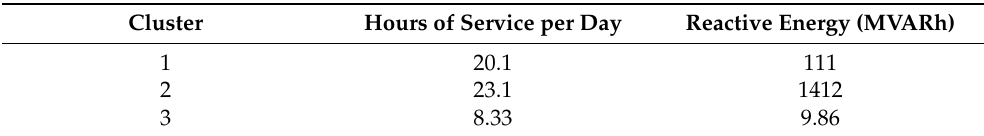
Table 5. Representative means of the municipality clusters by K-means.